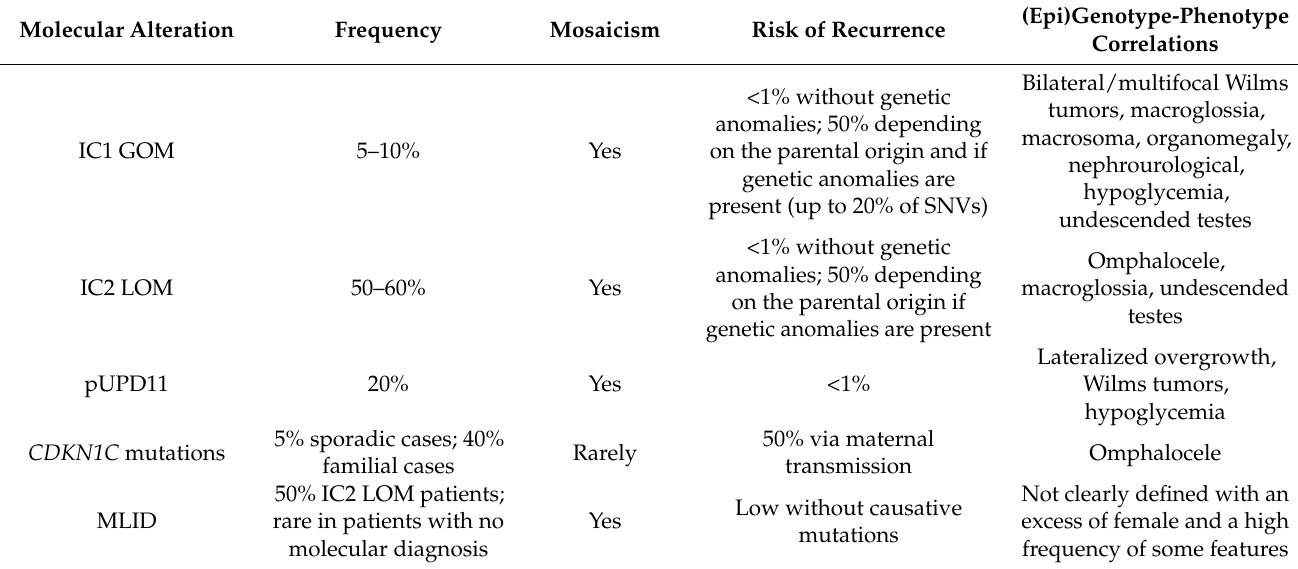
Table 5. Molecular alterations observed in BWS patients, recurrence risk and (epi)genotype-phenotype correlations. Molecular